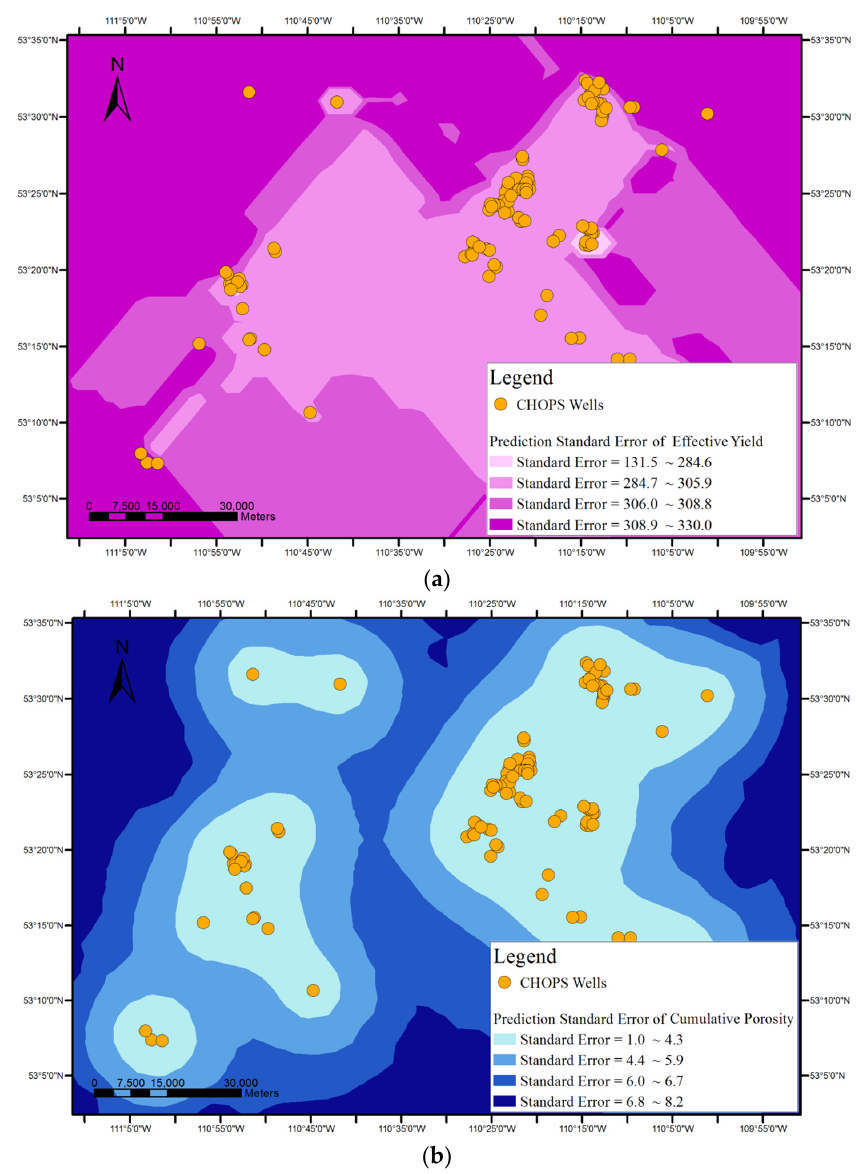
Figure 13. Prediction error maps of ( a ) the antecedent item of the rule (cumulative porosity); and ( b ) the consequence item of the rule (effective yield).